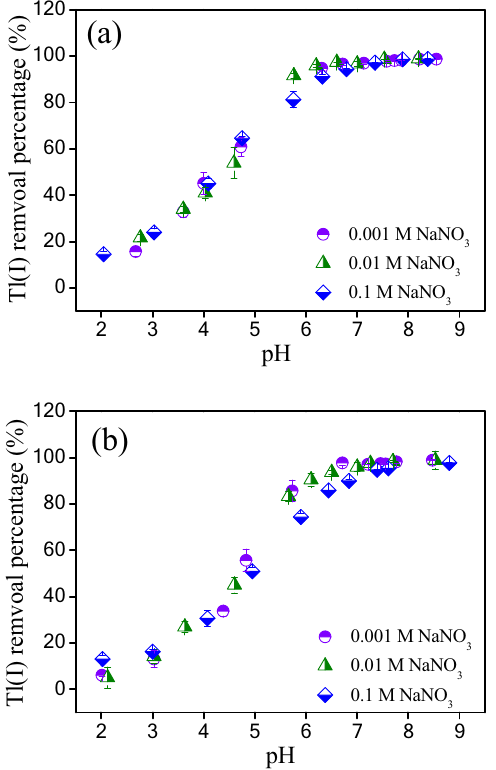
Figure 6. Effects of solution pH and ionic strength on Tl(I) adsorption by TiO 2 I ( a ) and TiO 2 II ( b ). Experimental conditions: Initial Tl(I) concentration: 30 mg/L; adsorbent dosage: 0.2 g/L; T: 25 ± 1